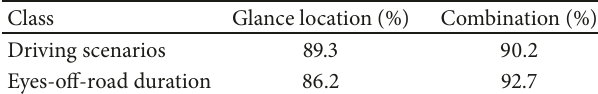
Table 2: Classification accuracies of driving scenario identification and eyes-off-road duration prediction using visual features of glance location and combination of glance location and duration.